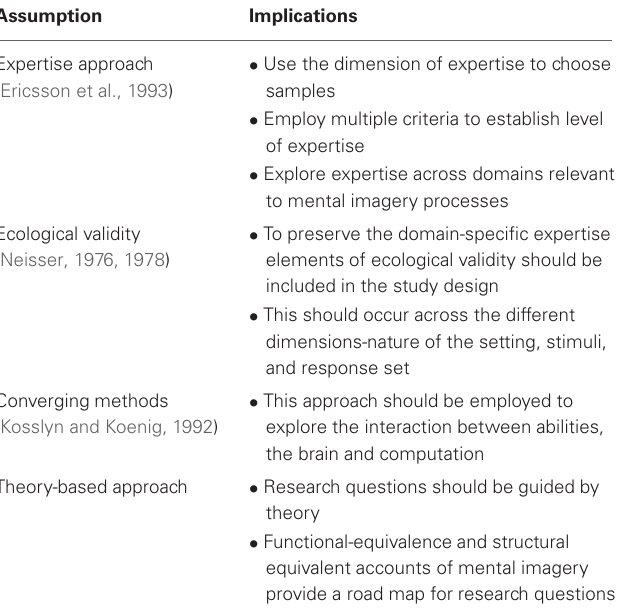
Table 3 | Proposed assumptions of the strength-based approach.